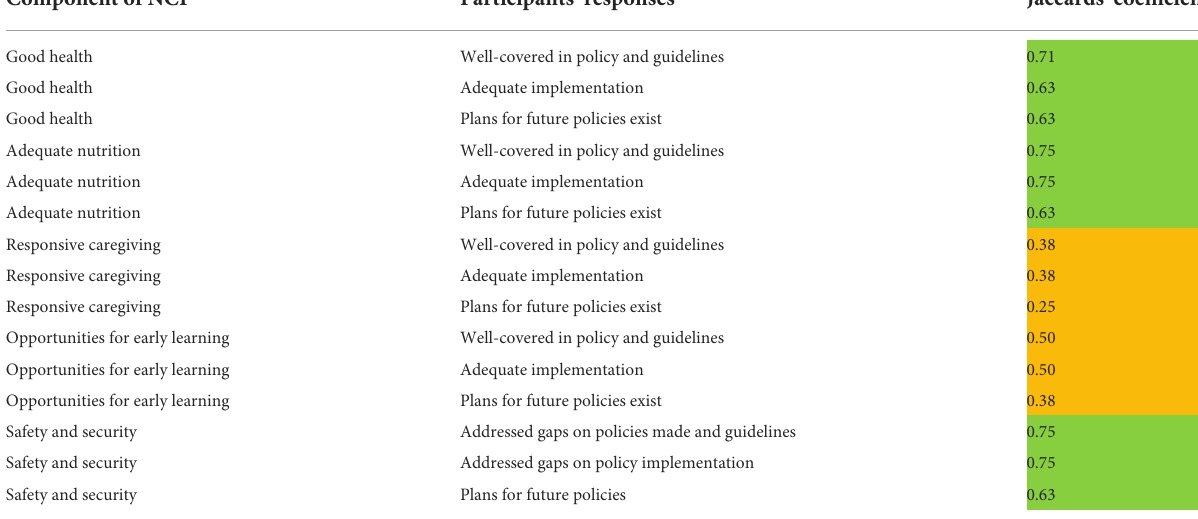
TABLE 5 Relationship between NCF components and policy-maker perceptions of policy